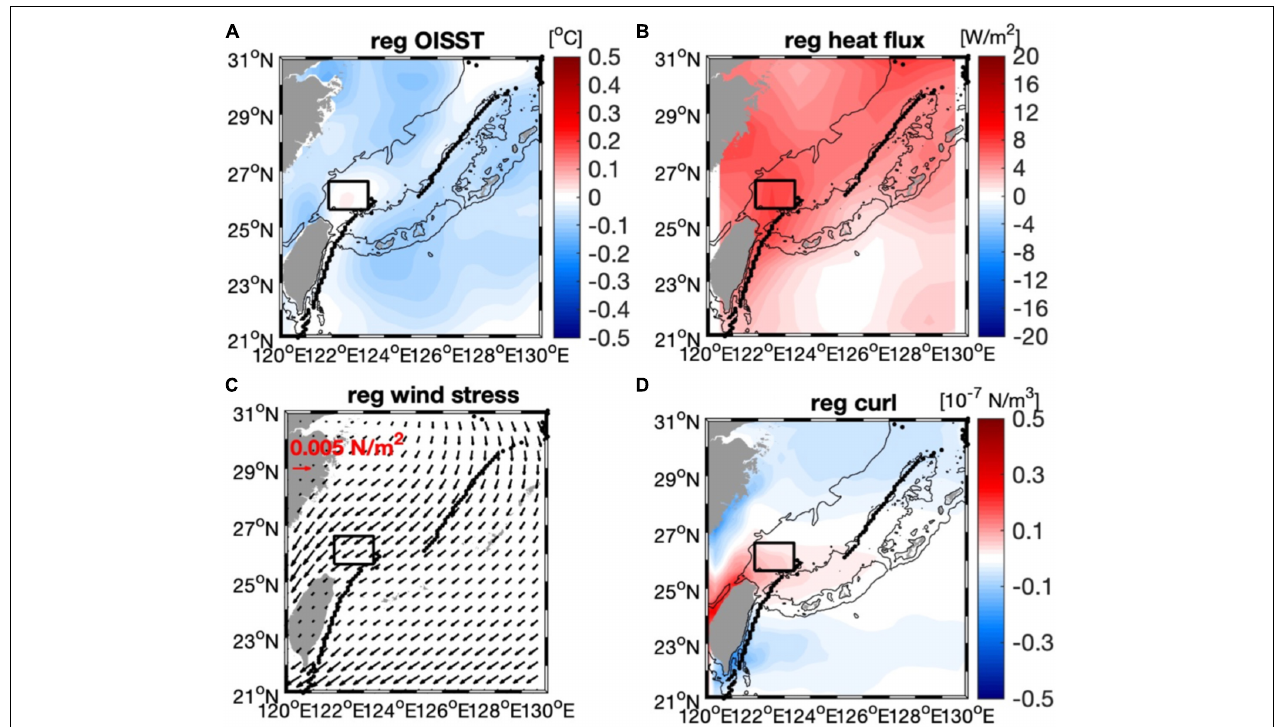
FIGURE 8 | Regressed anomalies of (A) SST, (B) surface heat flux, and (C,D) wind stress and wind stress curl targeting the KSI strength mode. The R-squared values are 0.37, 0.73, 0.76, and 0.81, respectively. The mean path of the Kuroshio is displayed as black dots. Black squares denote the KSI